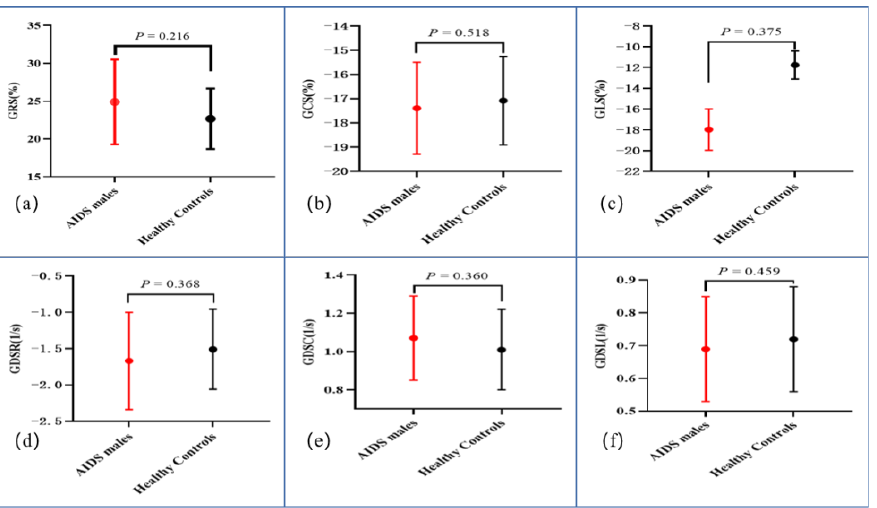
Figure 1. Plots for comparison of left ventricular global radial strain ( a ), global circumferential strain ( b ), global longitudinal strain ( c ), global diastolic strain rate radial( d ), global diastolic strain rate circumferential ( e ), and global diastolic strain rate longitudinal ( f ).